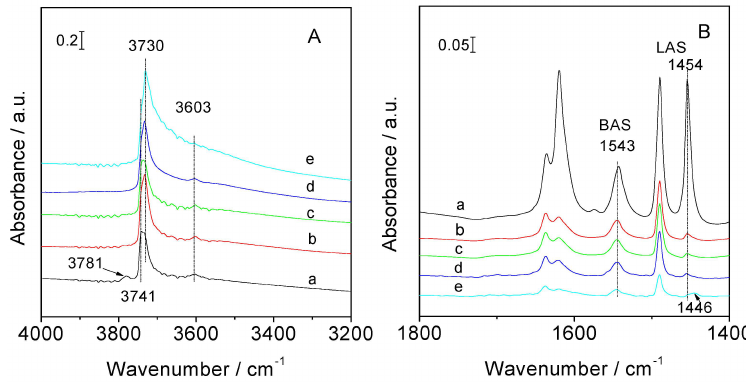
Figure 8. IR spectra of HB(12) ( a ); HB(77) ( b ); HB(77)-NT(1 M, 1 h) ( c ); HB(77)-NT(2 M, 1 h) ( d ); and HB(77)-NT(2 M, 16 h) ( e ) catalysts before ( A ) and after ( B ) pyridine was absorbed and then desorbed